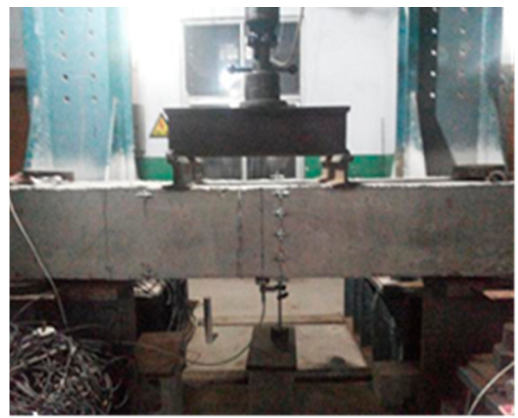
Figure 4. The static loading test.